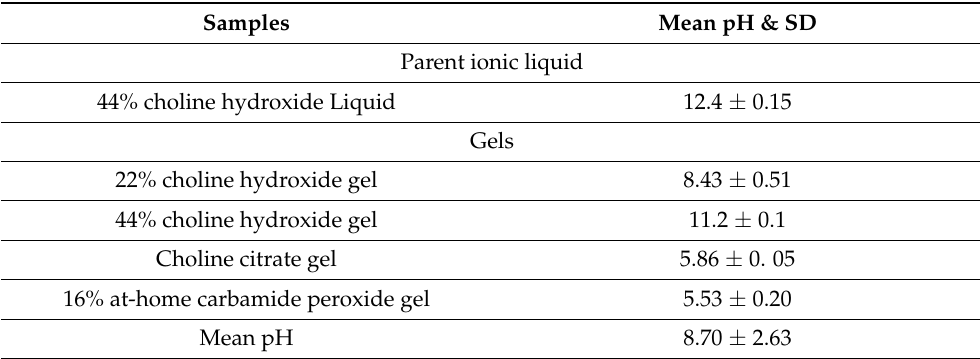
Table 2. Mean pH and SD of parent ionic liquid and gels.